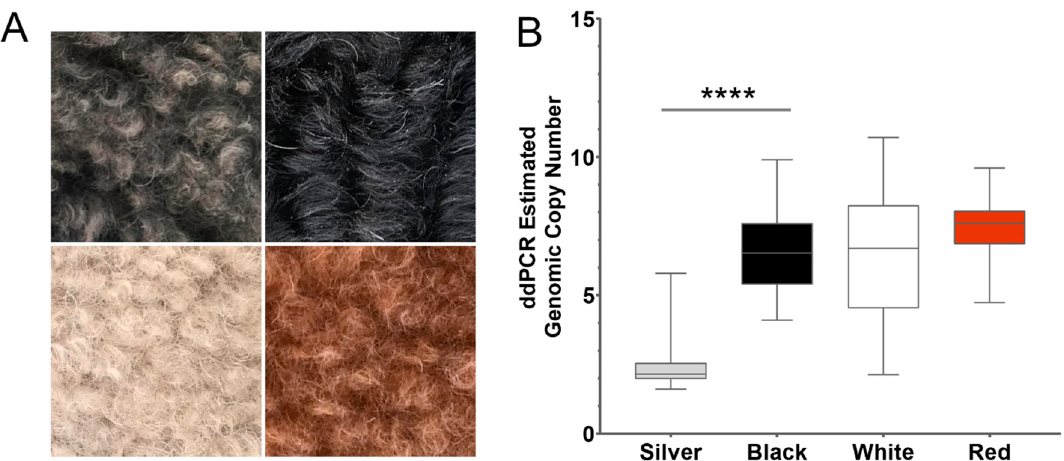
Figure 3. Eumelanin and pheomelanin-based Poodle coat colors and CNV genotypes. ( A ) Representative Poodle hair samples from eumelanin low intensity silver (top left), eumelanin high intensity black (top right), pheomelanin low intensity cream (bottom left), and pheomelanin high intensity red (bottom right). ( B ) Genomic copy number measured with digital droplet PCR from high and low intensity Poodles with pheomelanin and eumelanin-based coat colors. Silver compared to black was significant ( p = 1.5 × 10 − 8 ) while white compared to red was not. Sample numbers from left to right are as follows: n = 27, n = 425, n = 21, and n = 29. **** = highly